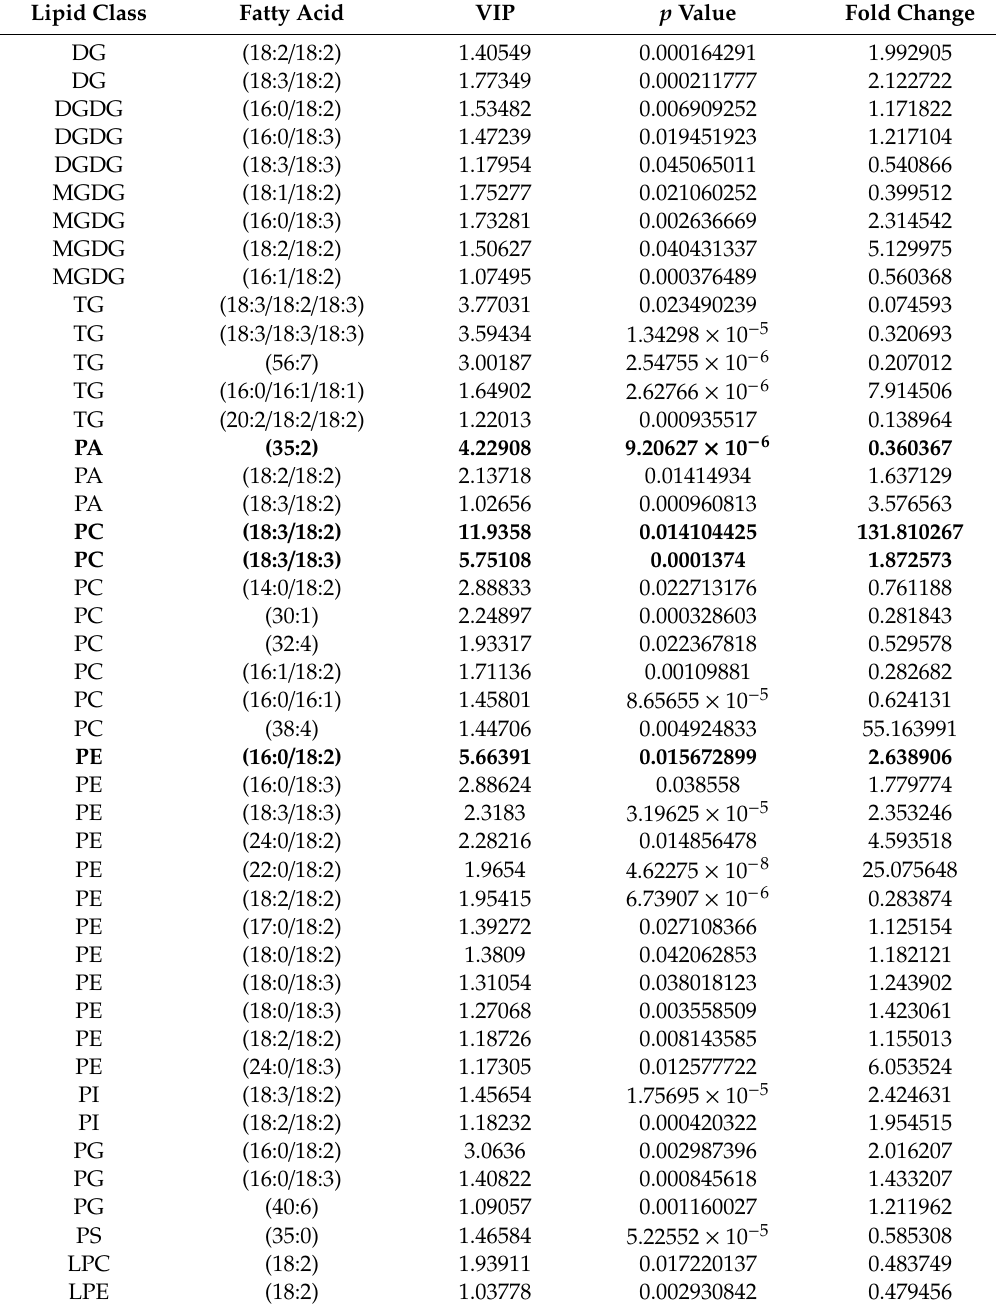
Table 1. The lipids with significant di ff erences of banana fruit during chilling injury. VIP > 1 and p value < 0.05 were applied to determine these significantly di ff erent